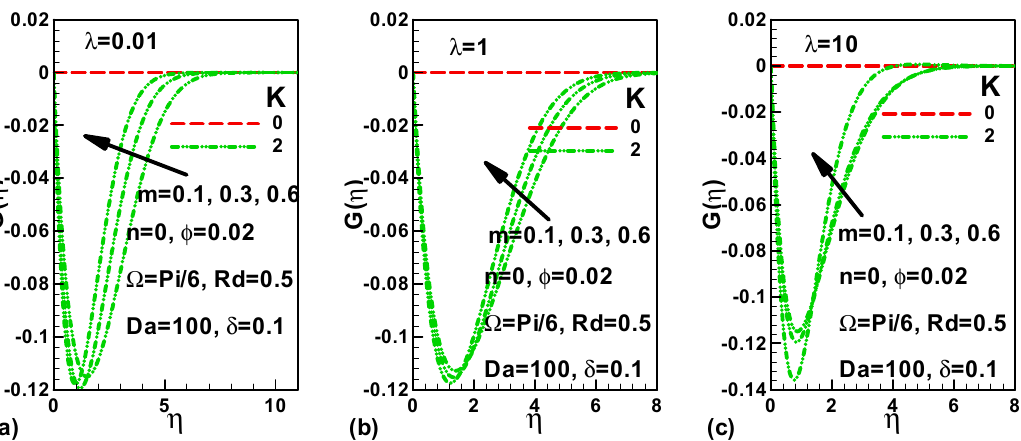
Figure 6. Variation of dimensionless microrotation with pressure gradient parameter for ( a ) forced convection, ( b ) mixed convection, and ( c ) free convection.